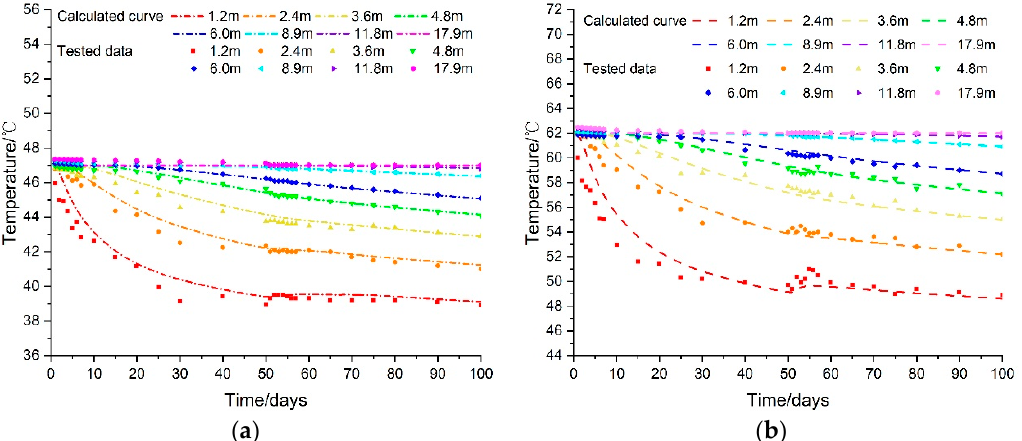
Figure 9. Comparison of the surrounding rock temperature measured value and predicted value: (a) Test Location 1 and (b) Test Location 2.